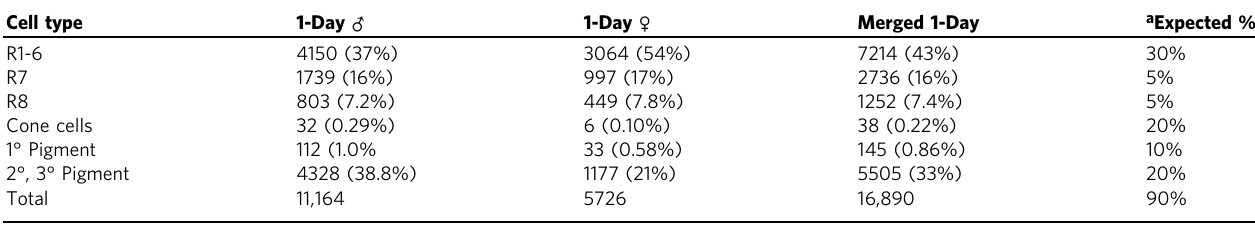
Table 3 Number of male or female cells by cell type in merged data